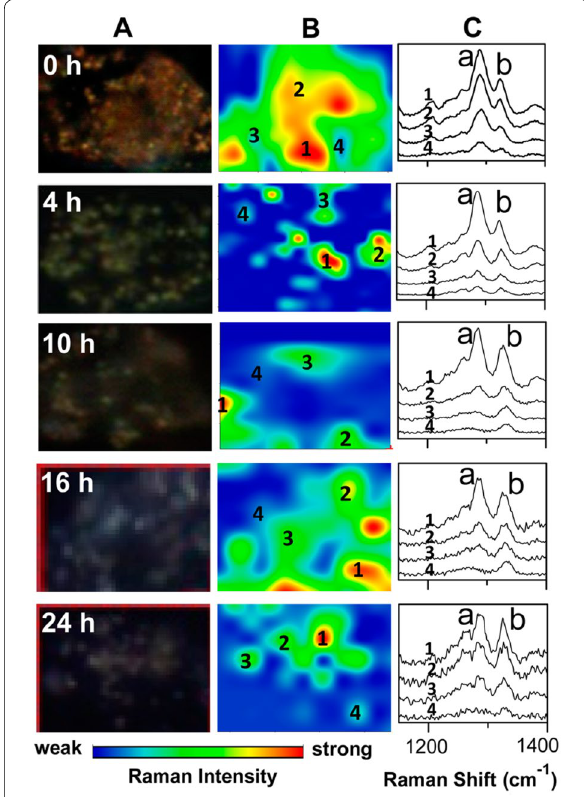
Fig. 15 SERS mapping to monitor the metabolism of 6MP in individual A549 cells over time (the uptake of Au@Ag‑6MP by the incubation for 5 h). A Dark‑field optical images of Au@Ag‑ 6MPuploaded cells with different incubation times in fresh culture medium (0, 4, 10, 16, and 24 h). B SERS images mapped with the Raman bands at 1286 cm − 1 (0 h) and 1330 cm − 1 (4, 10, 16, and 24 h). C The corresponding Raman spectra at the indicated sites in the left Raman images. (The color bar indicates the Raman signal